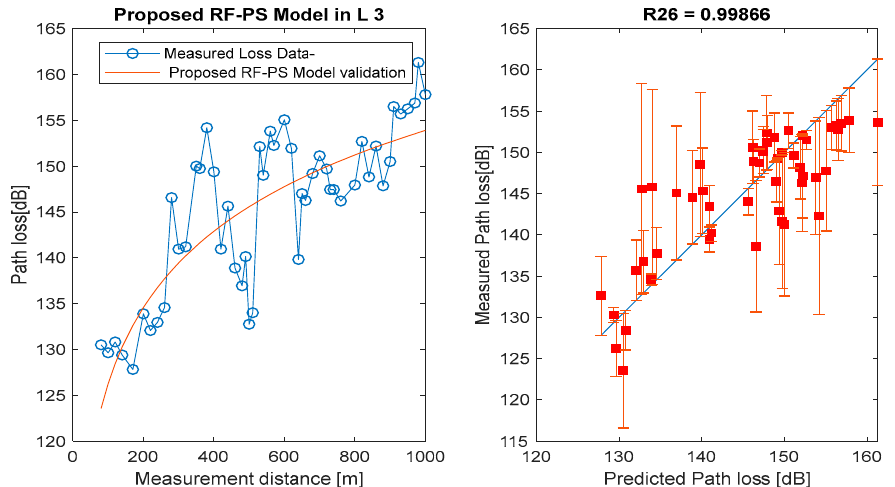
Figure 34. Measured path loss and the proposed hybrid RF-PS model validation plot using another site in location 3.